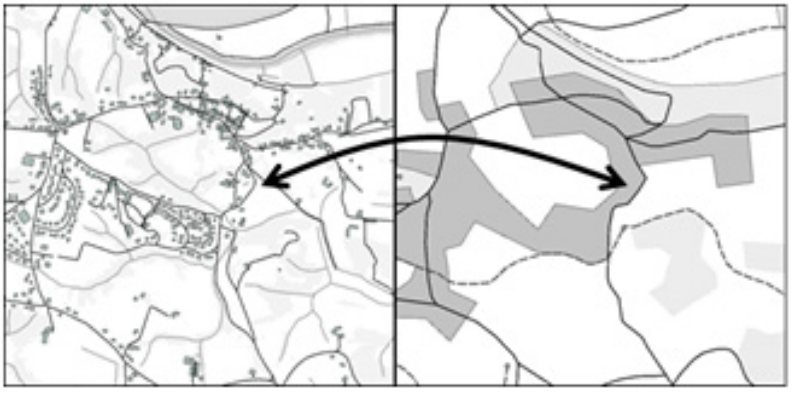
Figure 1: The matching problem. A pair of identical features in two different representa- tions of the same